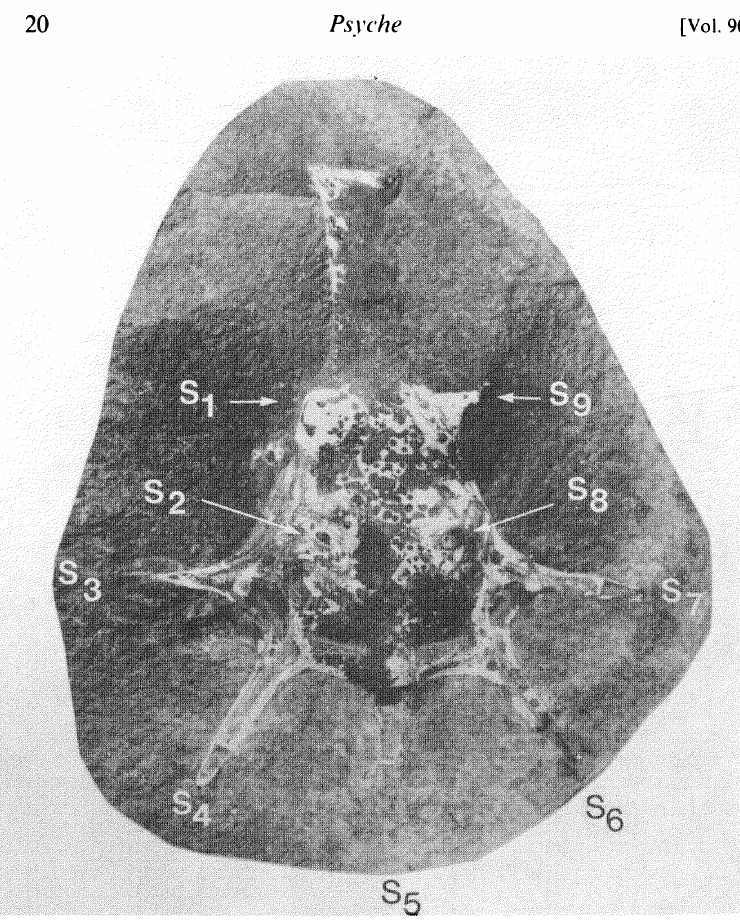
Fig. 8. Gerarus danielsi, photograph of the prothorax, PE 32029. Total length of prothorax, not including spines, 21 mm,